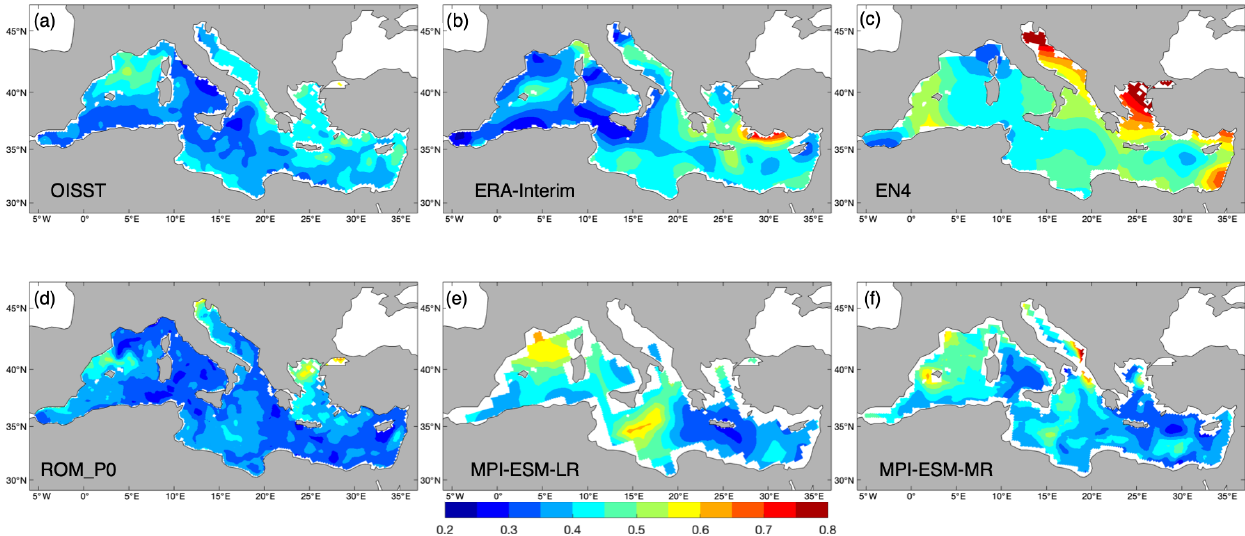
Figure 16. Yearly mean SST standard deviations (in ◦ C) for the 1982–2012 period: OISST (a) , ERA-Interim (b) , EN4 (c) , ROM_P0 (d) , MPI-ESM-LR (e) and MPI-ESM-MR (f)